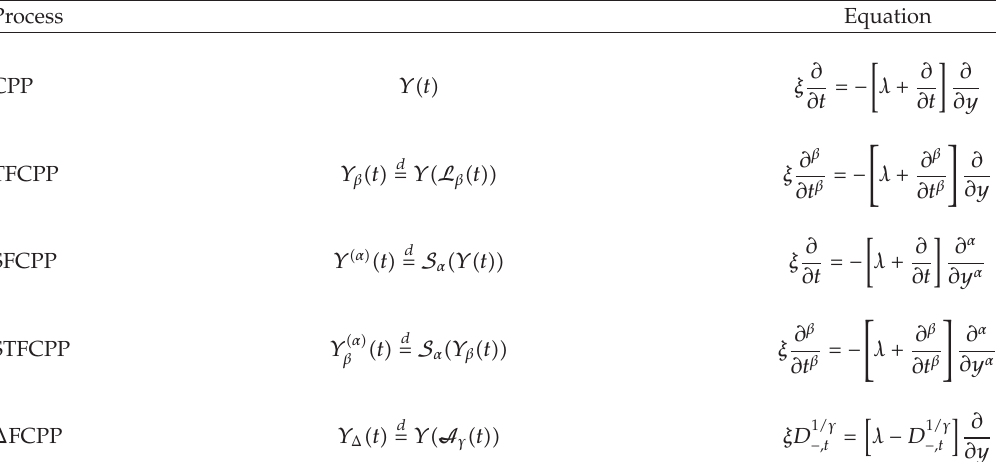
Table 1: Main results in finite domain.